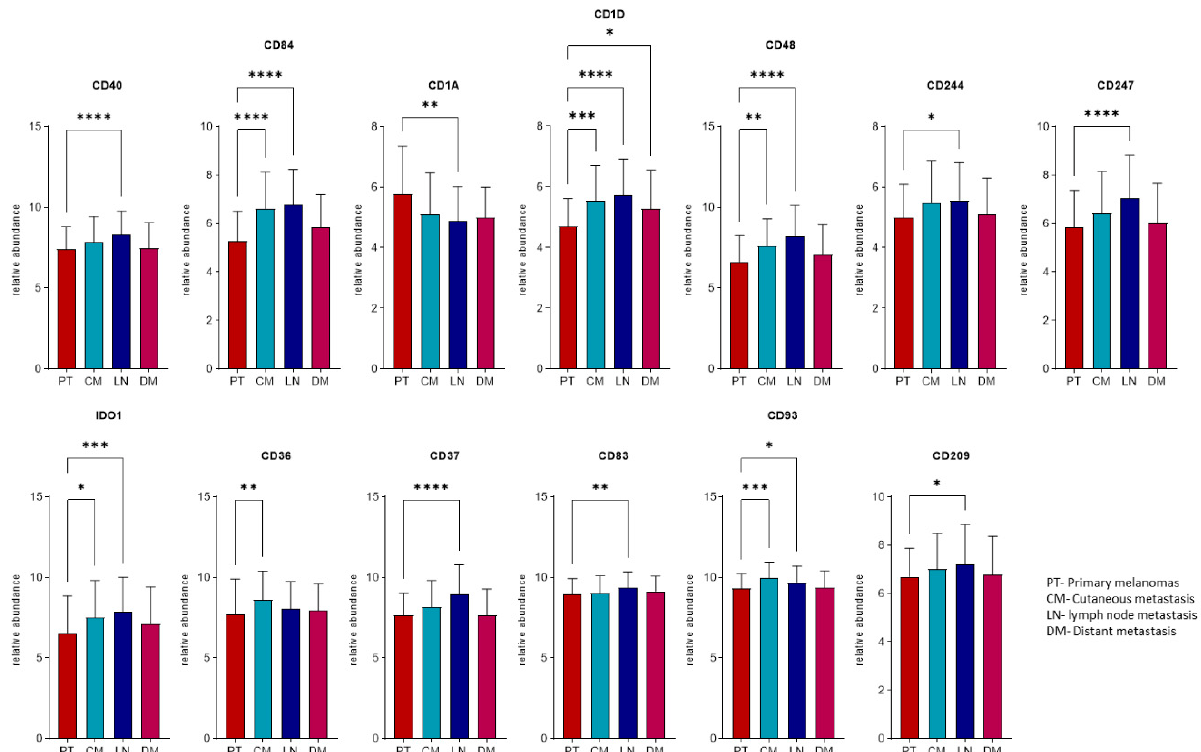
Figure 5. Relative abundance levels of the transcripts differentially expressed in at least one group of metastases relative to primary melanomas. Asterix represents the level of significance (* p < 0.05; ** p < 0.01; *** p < 0.001; **** p < 0.0001) using analysis of variance (ANOVA) test adjusted with the Benjamini–Hochberg method and an additional Tukey–Kramer post hoc test for each ANOVA analysis.